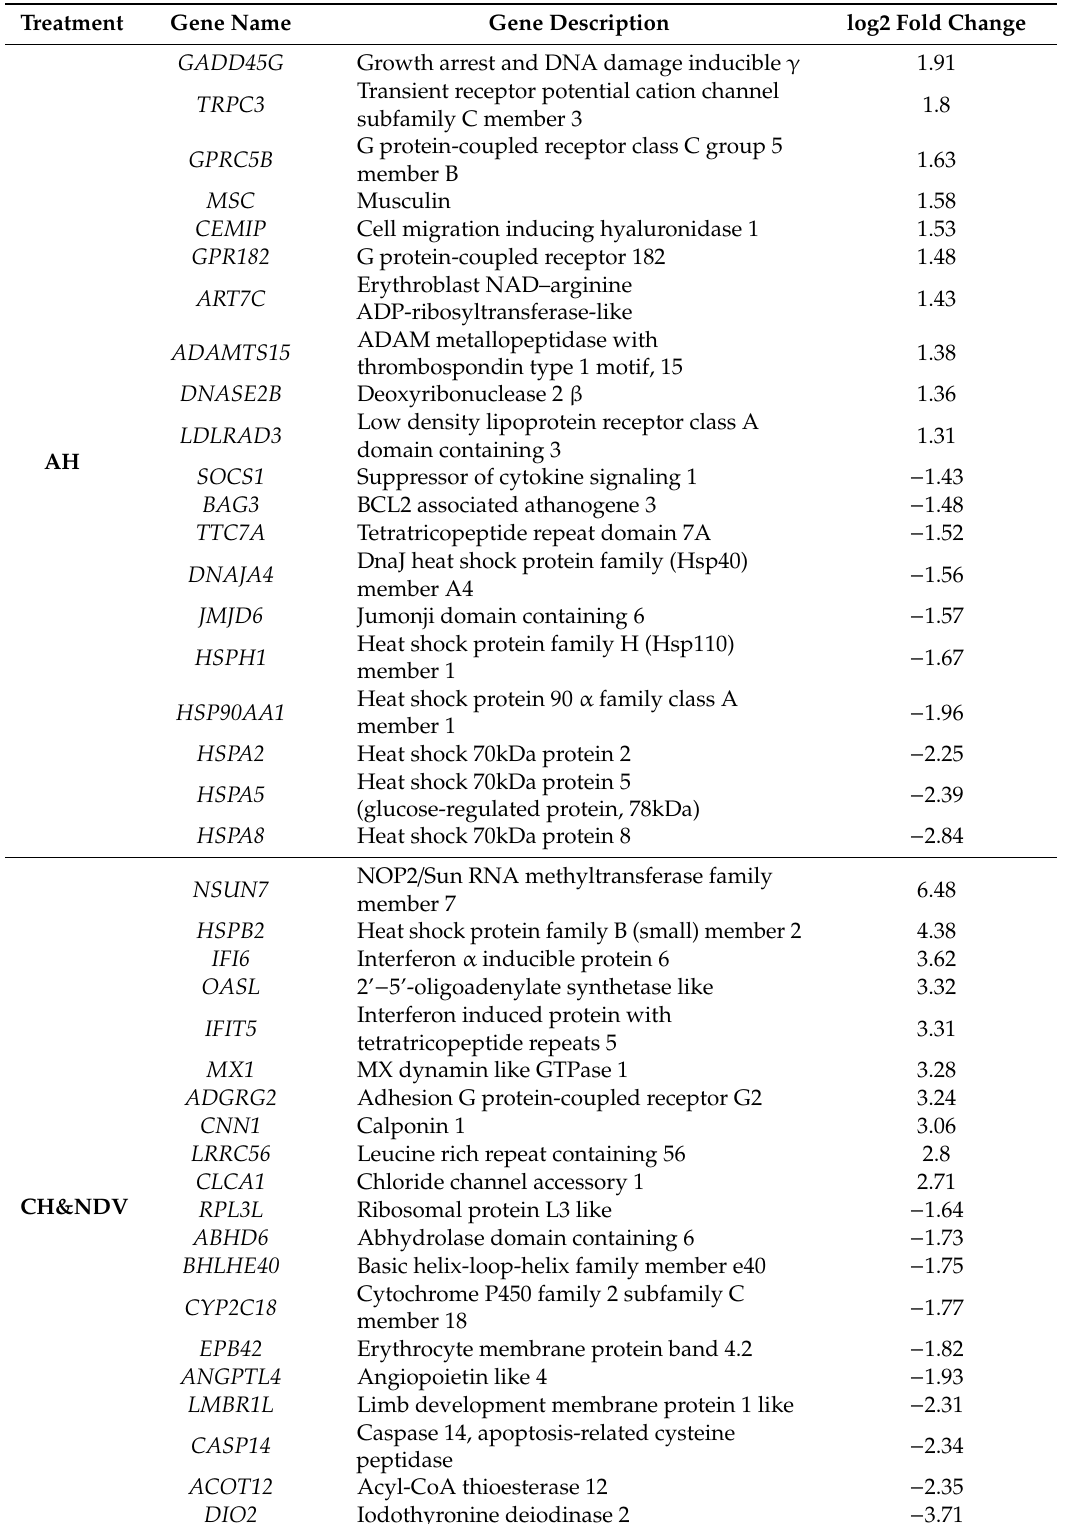
Table 8. Top 10 up- and down-regulated DEGs in the Leghorn